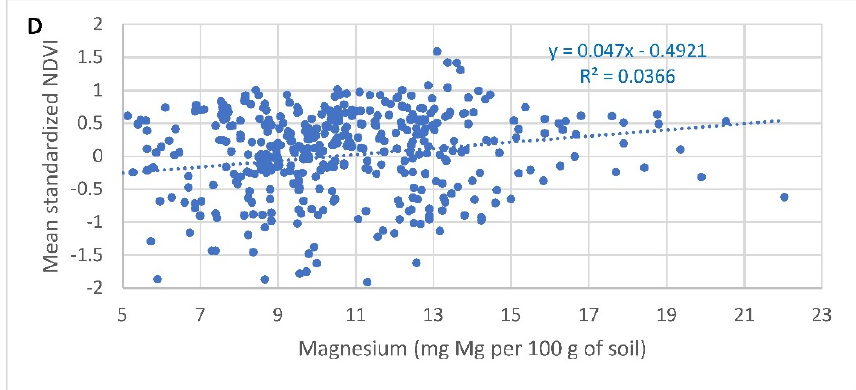
Figure 4. Relationships between NDVI versus pH and content of macronutrients.